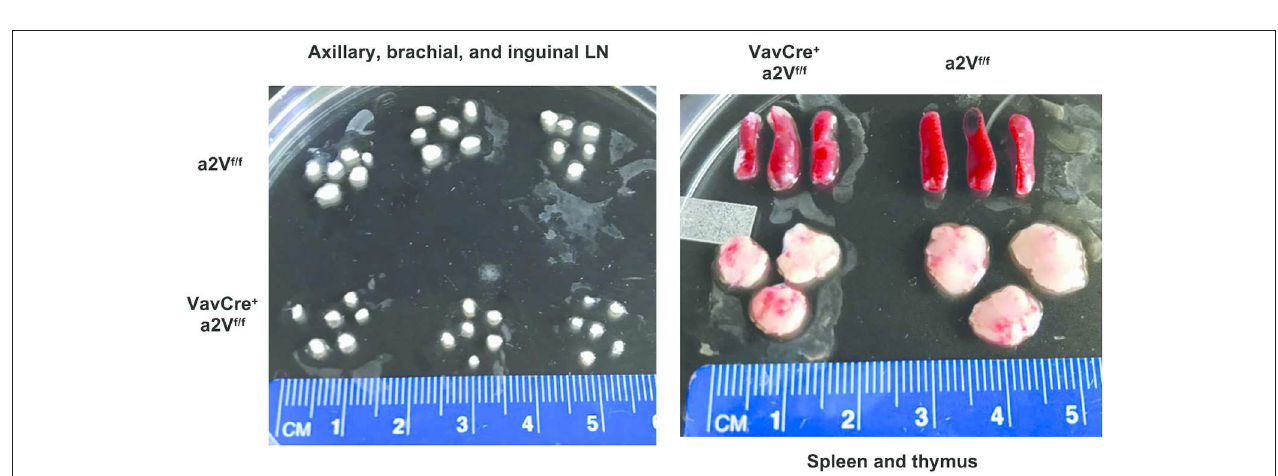
FIGURE 2 | Reduced lymphoid organ size in Vav Cre a2V fl / fl mice. Lymph nodes, spleens, and thymuses of Vav Cre a2V fl / fl mice are grossly reduced in size. The difference is most pronounced in the T cell dominated organs of lymph nodes and thymuses ( n = 3 each group).